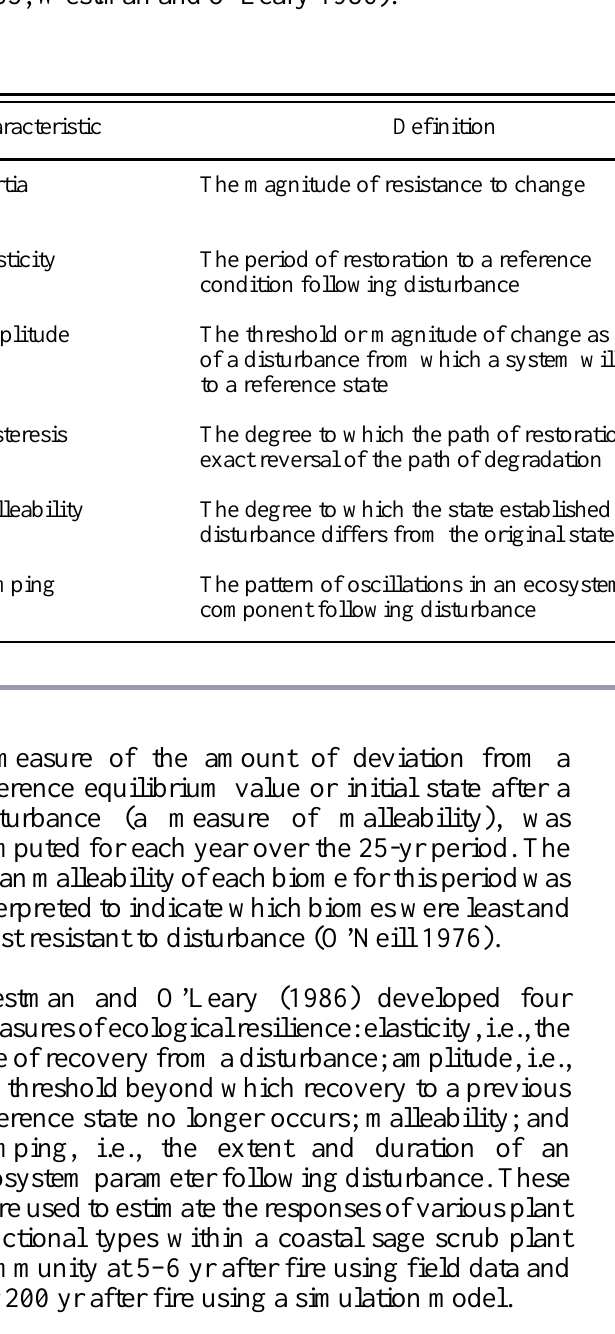
Table 1. Characteristics of ecological resilience and examples of their application (Orians 1975, Westman 1985, Westman and O’Leary